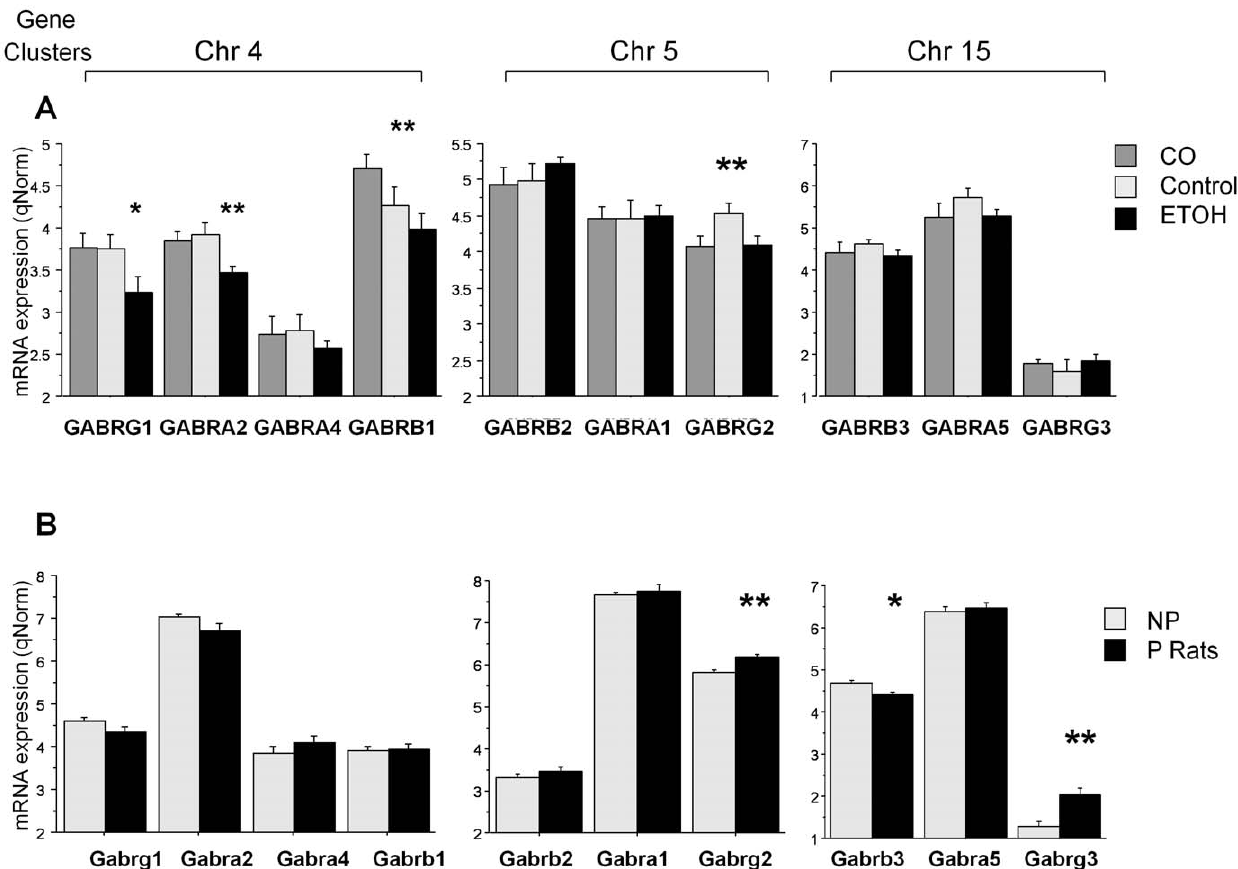
Figure 2. The Expression of GABAA Receptor Subunit Genes in Human Samples and Rat Samples. The genes are grouped in the chromosomal 4, 5 and 15 clusters. ETOH=alcoholics; CO=cocaine addicts. Error bars: standard errors. ** FDR p , 0.05; * FDR p # 0.06.